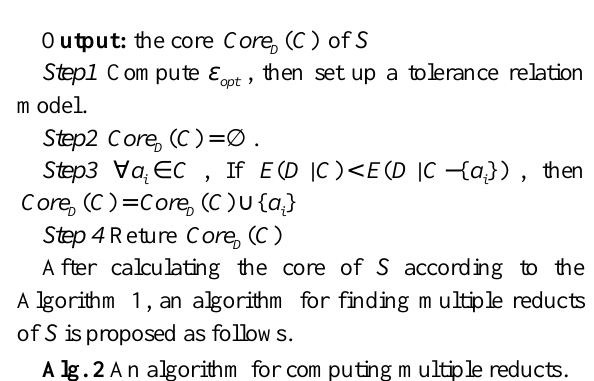
Algorithm 1, an algorithm for finding multiple reducts of S is proposed as follows.